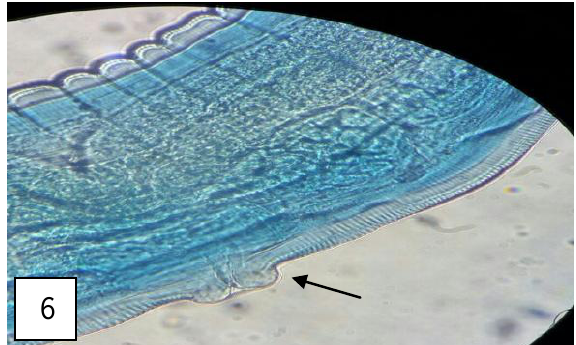
Figure, 6: Reveals the lips and orifice of the vulva in the ventral aspect (x40).